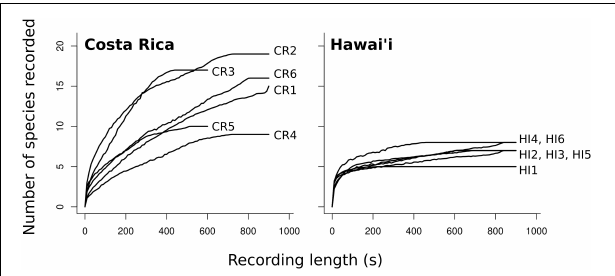
FIGURE 1 | Species accumulation curves (mean of 500 iterations) for each of six recording locations in Costa Rica and